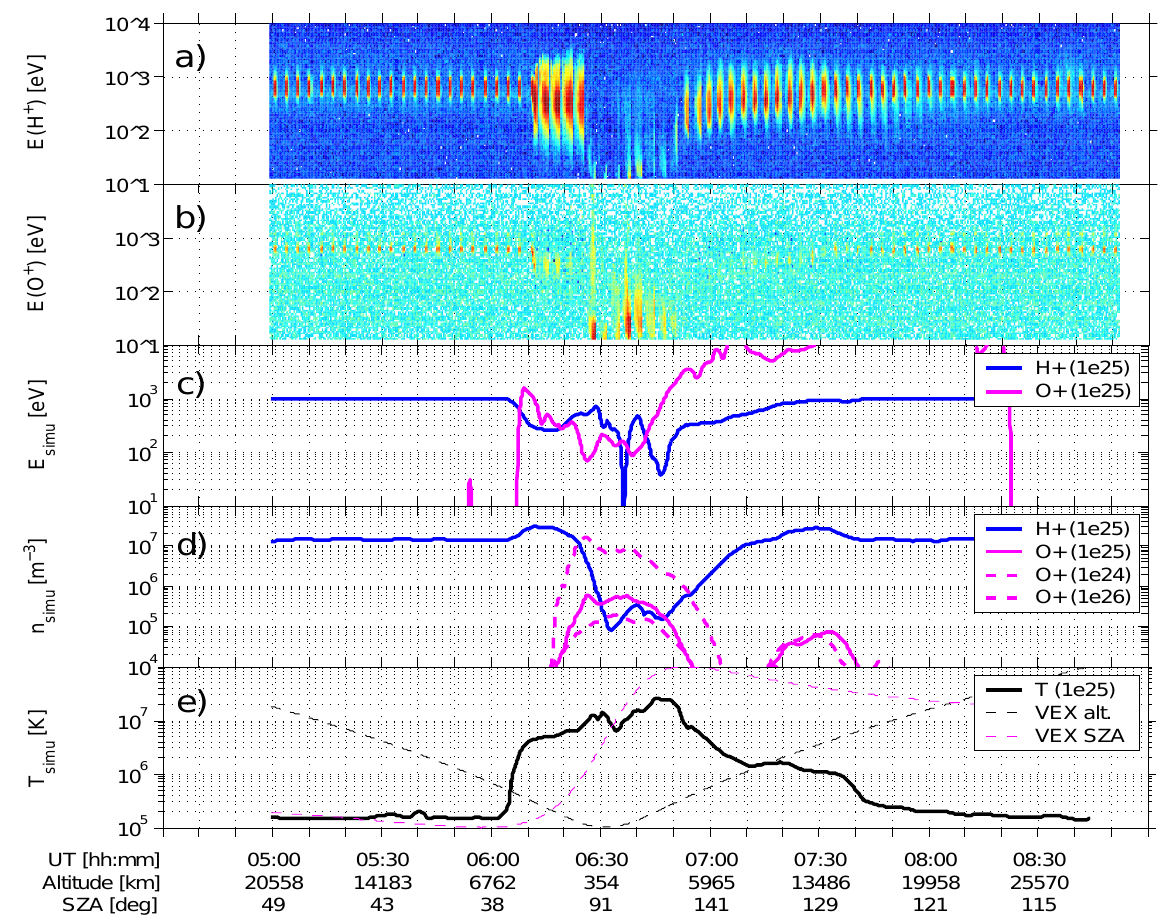
Fig. 3. A comparison of the H + and O + time-energy spectra observed by VEX/ASPERA-4 (two uppermost panels) and the bulk flow energy mnV 2 ) and density ( n ) of the H + and O + ions and the total plasma temperature ( T ) from the nominal HYB-Venus simulation run ( E = 1 2 (three lowest panels) along the orbit shown in Fig. 1. Coloring in the spectral plots denotes particle counts per second. In the simulation plots two different ion populations are shown: the solar wind H + (blue line) and the planetary O + (magenta). In addition, dashed magenta lines in the density panel are the O + densities in the lower (10 24 ) and higher (10 26 ) emission